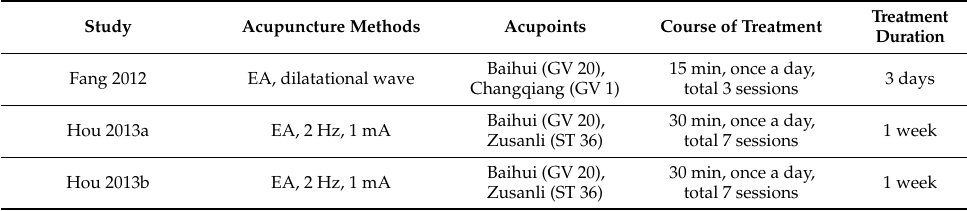
Table A17. Details of Acupuncture Treatment